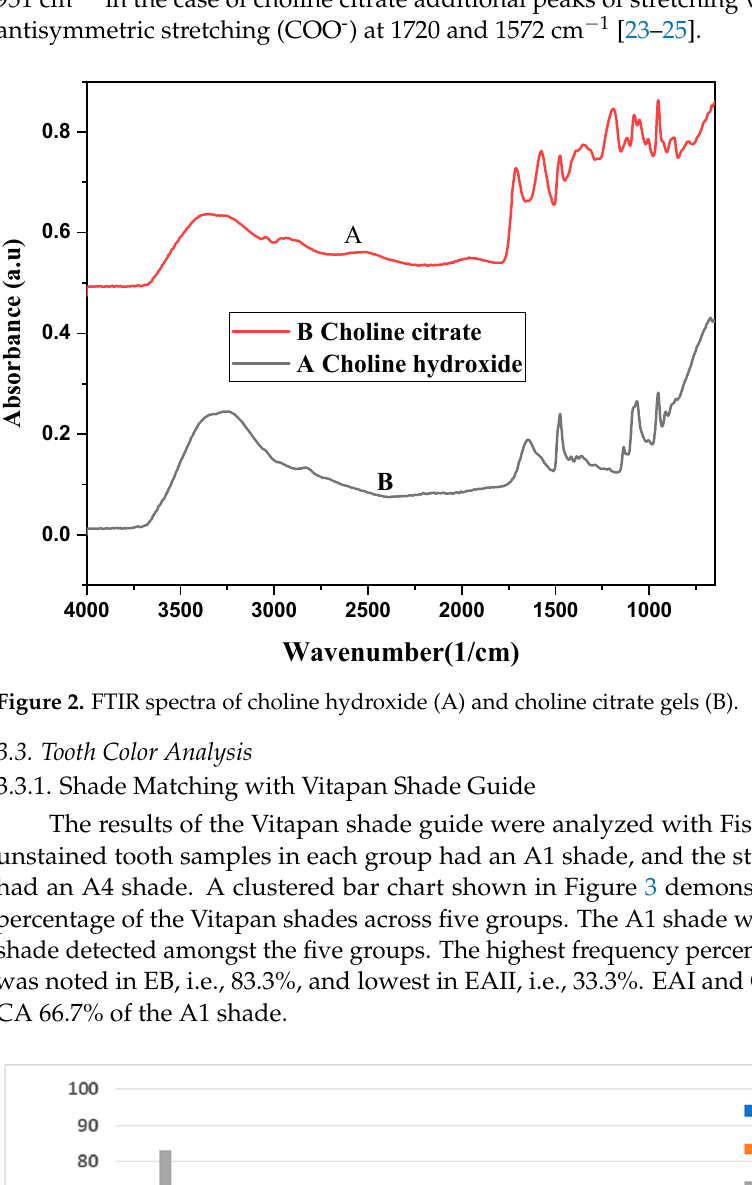
Figure 1. FTIR spectra of (A) 44% choline hydroxide ionic liquid, (B) 44% choline hydroxide ionic liquid gel, and (C) 22% choline hydroxide ionic liquid gel .